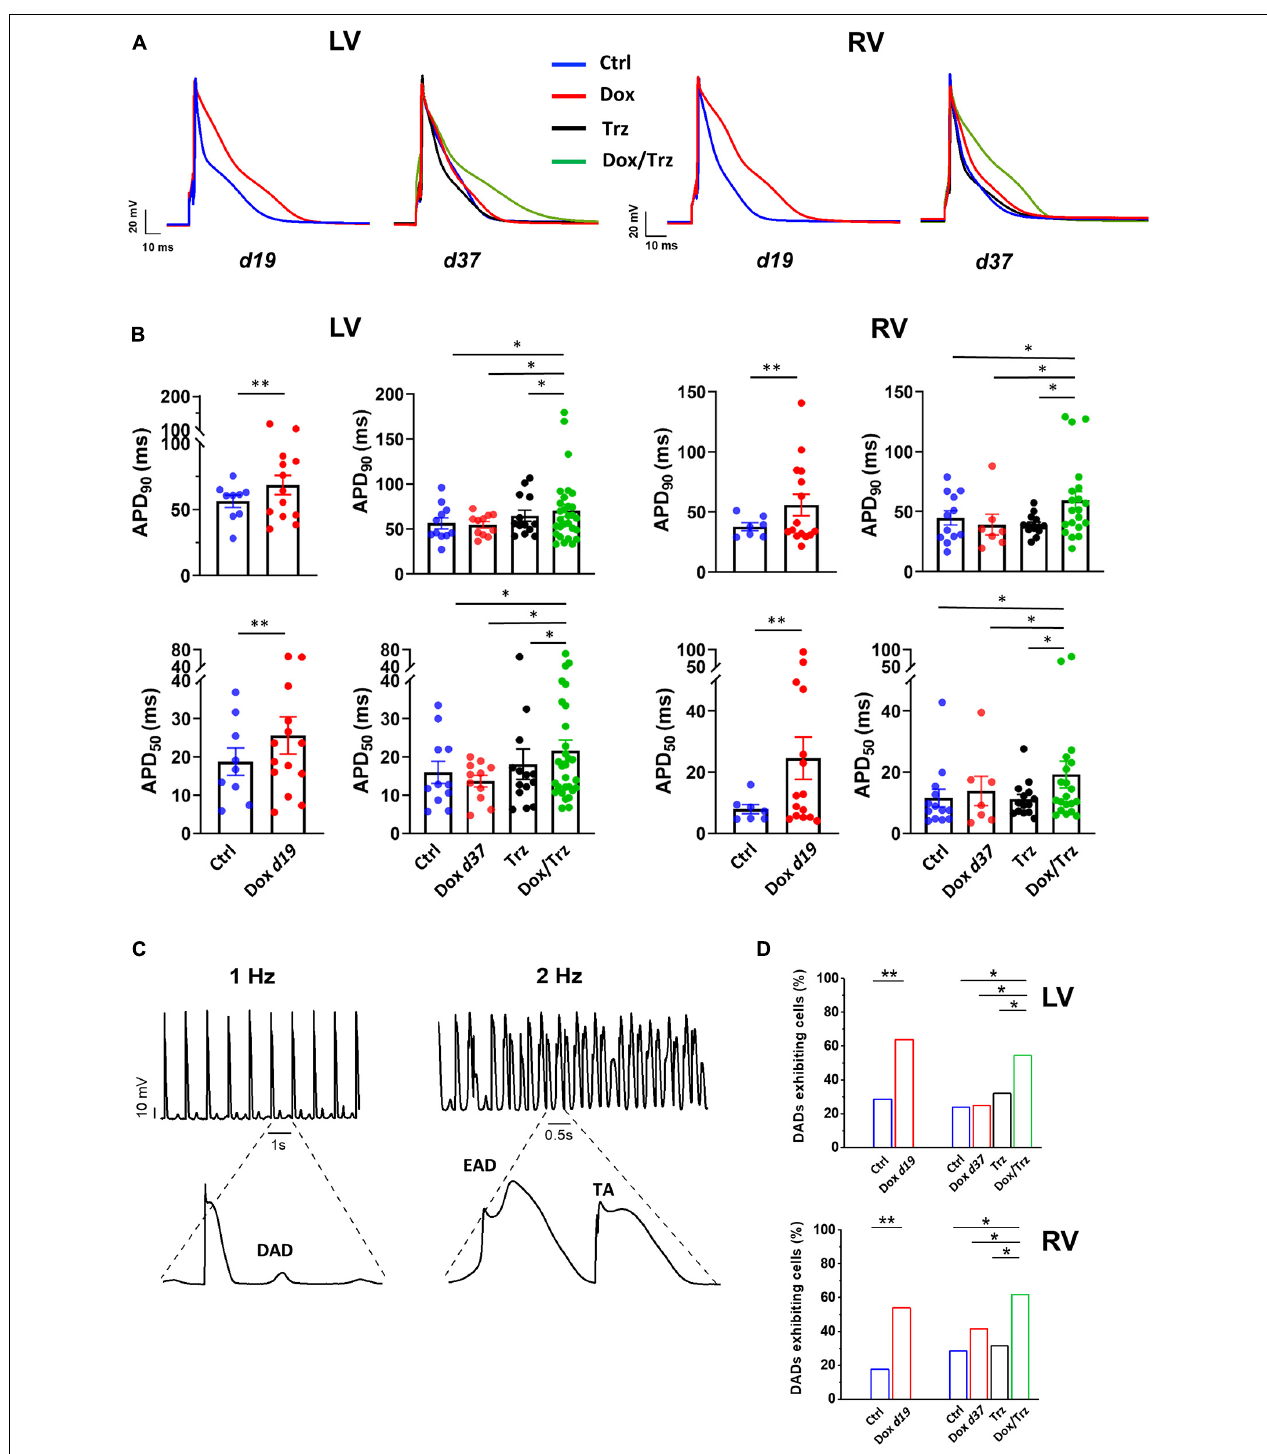
FIGURE 3 | Effects of Dox and Trz on electrical activity. (A) Electrical recordings of stimulated (1 Hz) APs in LV and RV CMs in all groups. Measurements were performed at d19 and at d37 (before and after Trz administration, respectively). (B) Quantitative analysis of APD 50 and APD 90 showing APD prolongation in the Dox group (at d19) and in the Dox/Trz group (at d37). (C) Electrical recordings showing DAD at 1 Hz-stimulation, as well as EAD and trigger activity (TA) at 2 Hz-stimulation in the Dox/Trz group. (D) Quantitative analysis of cells (%) exhibiting DADs at 1 Hz-stimulation. Data were acquired at d19 and at d37 (see above). Unpaired Student’s t -test and one-way ANOVA was used to test for significant differences at d19 and d37, respectively, in panel (B) . Chi 2 -test was used for comparison of categorical variables in panel (D) . Bars are mean ± SEM ( n = ≥ 12 cells from ≥ 3 rats/group; * p < 0.05; ** p < 0.01).